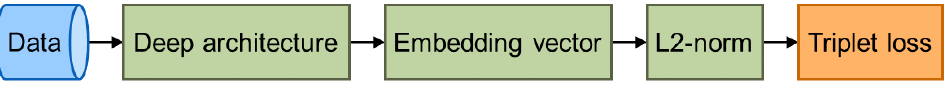
Figure 1. Existing triplet loss training